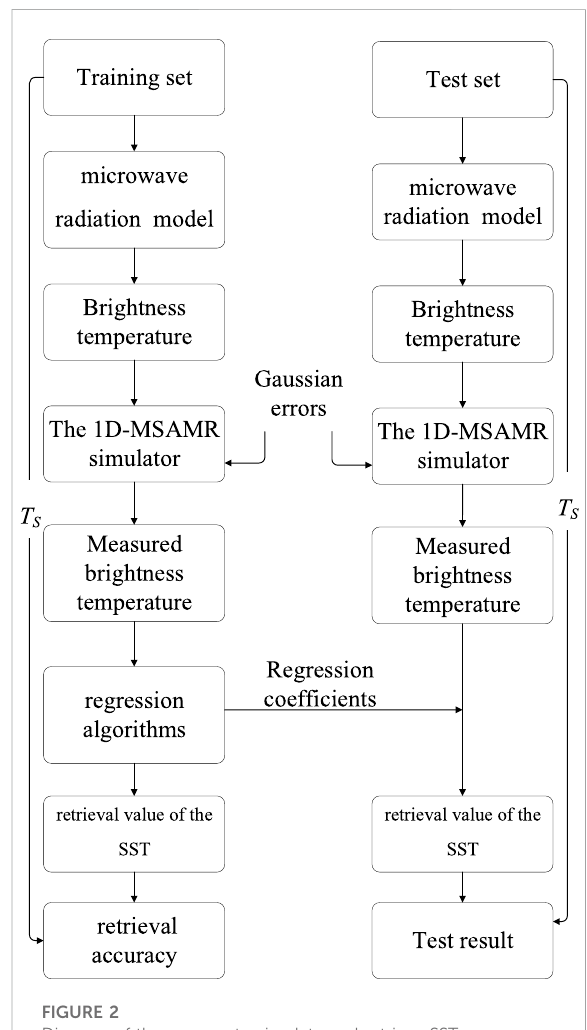
FIGURE 2 Diagram of the process to simulate and retrieve